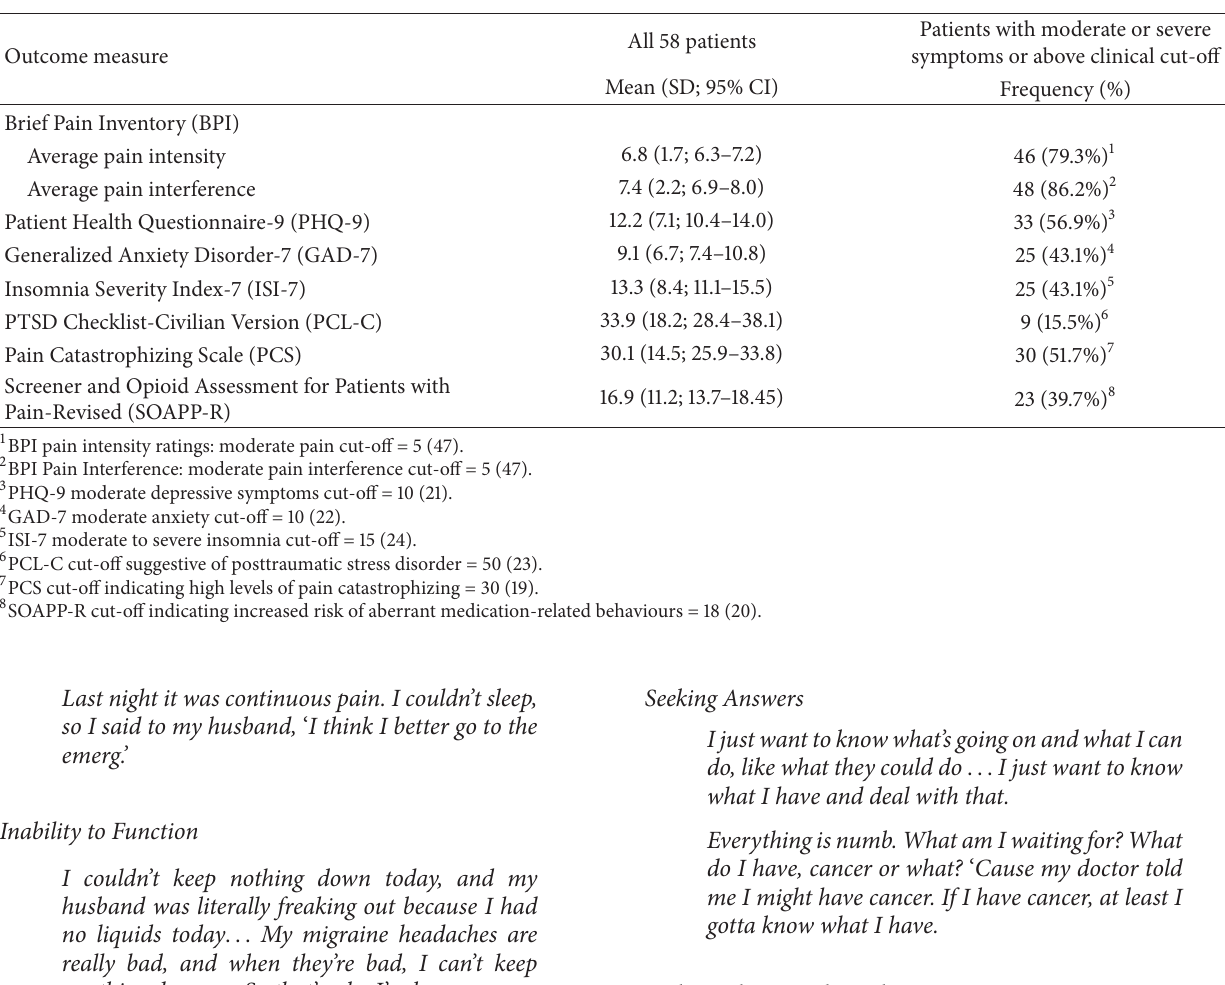
Table 3: Descriptive statistics for all outcome